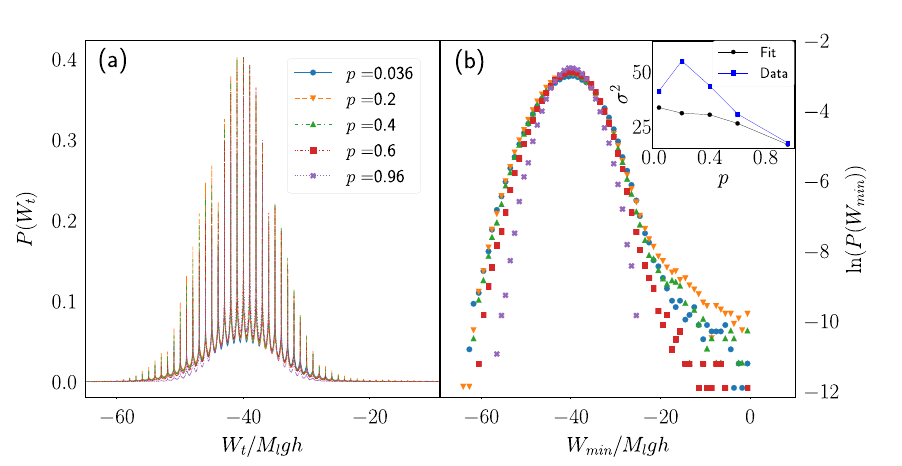
Figure 6. Work distribution at fixed load mass. ( a ) Pdf of the work performed by the engine on the load mass during a time window t = 40 ¯ t c for systems with M l = 1 and several values of p . ( b ) Logarithm of the local minima of the curves shown in ( a ). Inset: Variance of the distribution computed from a Gaussian fit to the data around its maximum (squares) and from the numerical computation using all the work data